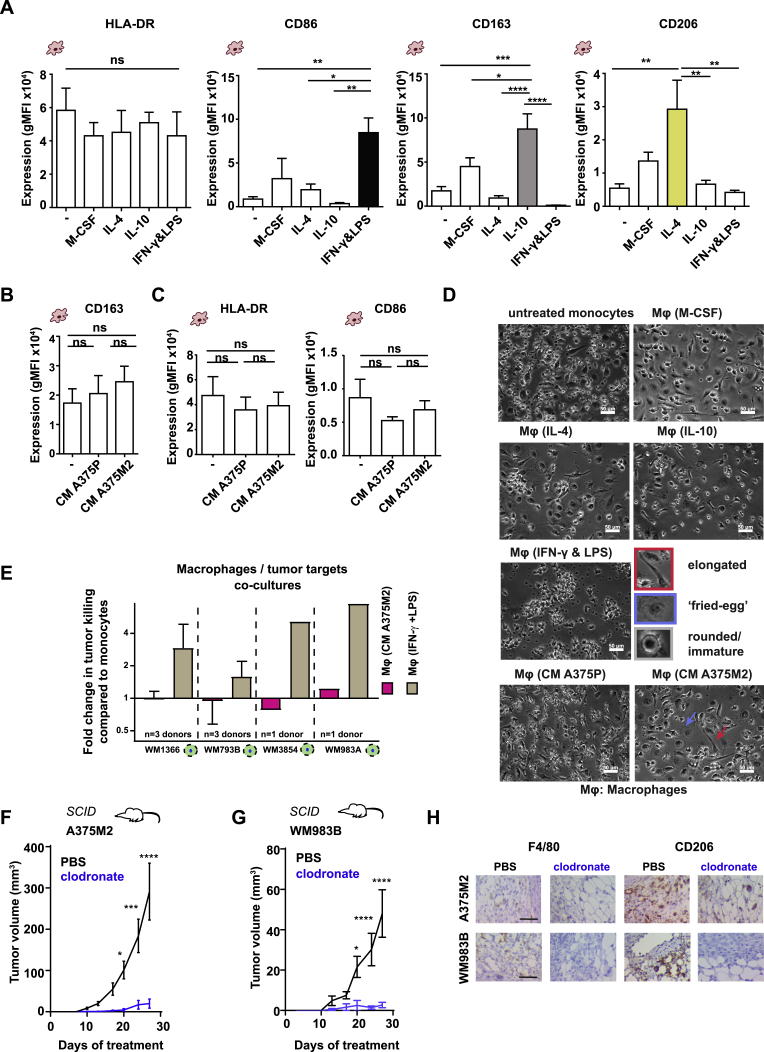
Amoeboid Melanoma Cells with High Myosin II Activity Induce Tumor-Promoting Macrophages, Related to Figure 3(A) Expression levels (geometric mean of fluorescent intensity, gMFI) of HLA-DR, CD86, CD163 and CD206 in macrophages after treatment with M-CSF (50ng/ml), IL-4 (20ng/ml), IL-10 (20ng/ml), IFN-γ & LPS (20ng/ml and 100ng/ml) or culture media only (-) (n = 5; 5 different healthy donors).(B and C) Expression levels (gMFI) of (B) CD163, (C) HLA-DR and CD86, in macrophages treated with CM A375P or CM A375M2 or culture media only (-) (n = 5; 5 different healthy donors).(D) Representative bright-field images of macrophages treated with M-CSF, IL-4, IL-10, IFN-γ & LPS or culture media only (-). Blue and red arrows show ‘fried-egg’ and elongated shapes, respectively. Scale bar, 50 μm.(E) Dead tumor targets (WM1366, WM793B, WM3854 and WM983A) upon co-culture with CM A375M2- or IFN-γ&LPS- stimulated macrophages. Data are presented as fold change versus the control untreated monocytes. Log2 scale is presented in y axis.(F and G) Tumor volume in (F) A375M2-xenografts and (G) WM983B-xenografts, upon depletion of macrophages via clodronate in SCID mice (n = 6 mice PBS group and n = 5 mice clodronate group).(H) Representative IHC images showing F4/80+ and CD206+ macrophage depletion upon clodronate administration in A375M2 and WM983B xenografts. Scale bar, 100 μm.(A–C and E–G) Graphs show mean ± SEM. (A–C) One-way ANOVA with Tukey post hoc test. (F and G) Two-way ANOVA with Bonferroni’s multiple comparison test.ns p > 0.05,∗p < 0.05,∗∗p < 0.01,∗∗∗p < 0.001,∗∗∗∗p < 0.0001.